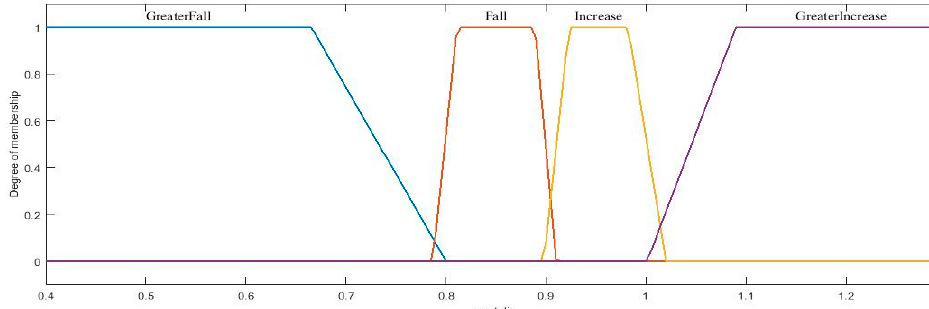
Figure 12. Systolic quotient input.